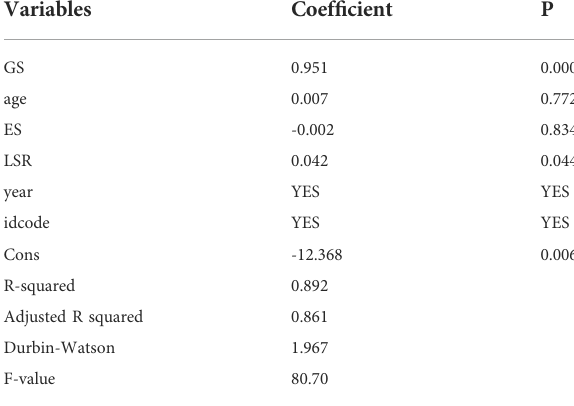
TABLE 8 Regression results of PO.